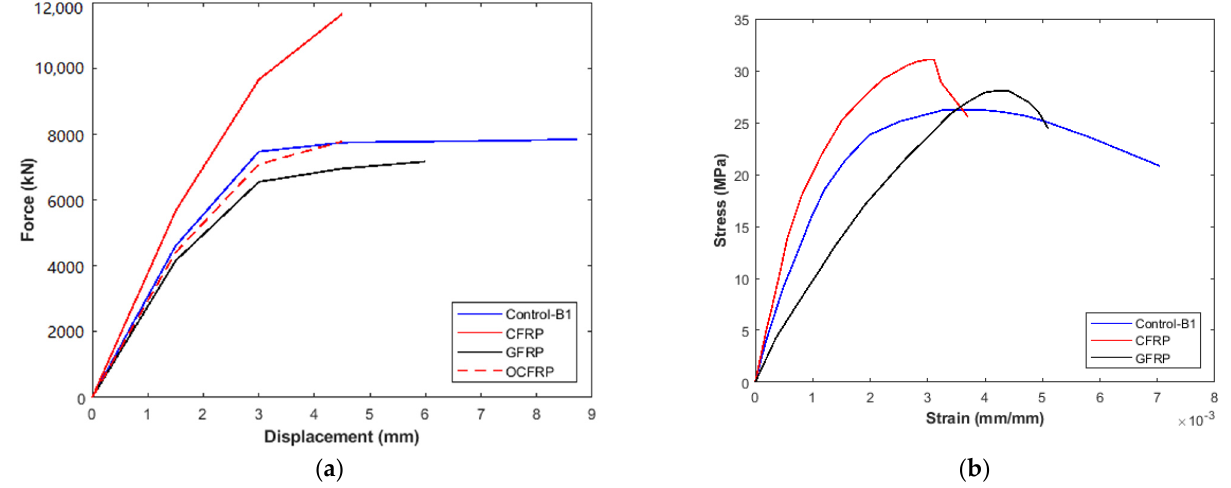
Figure 8. Group B ( a ) Load-Displacement diagram ( b ) Stress-Strain Diagram.